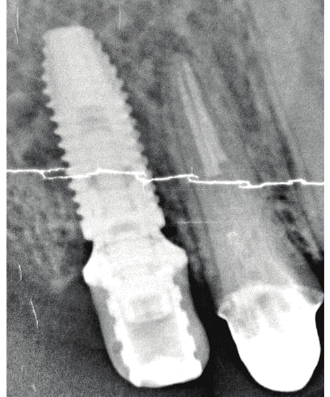
Figure 18: Checking the fit of the On1 base into the implant on the day of surgery.